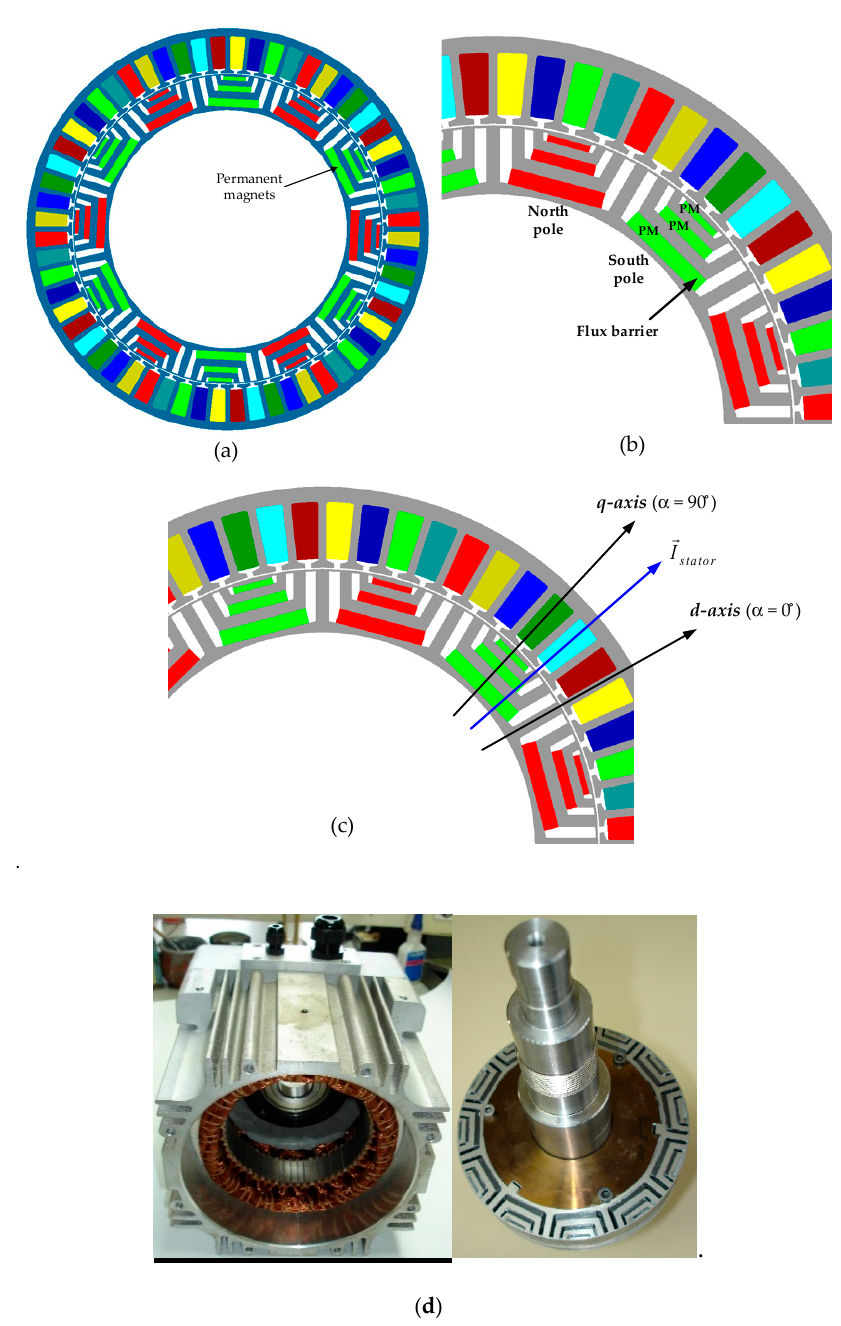
Figure 1. Layout of the analyzed five-phase permanent magnet assisted synchronous reluctance motor (fPMa-SynRM). ( a ) Stator and rotor arrangements. ( b ) Detail of the stator and rotor arrangements. ( c ) Stator current components ( d - and q -axis). ( d ) Stator and rotor of the analyzed fPMa-SynRM.